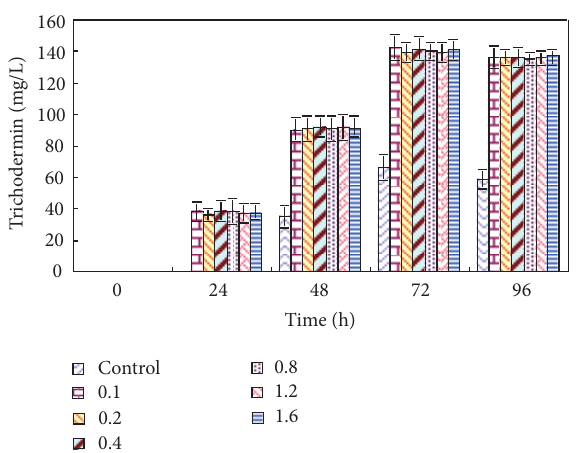
Figure 2: Influence of the concentration for nonviable R. solani (g/L) on trichodermin production.